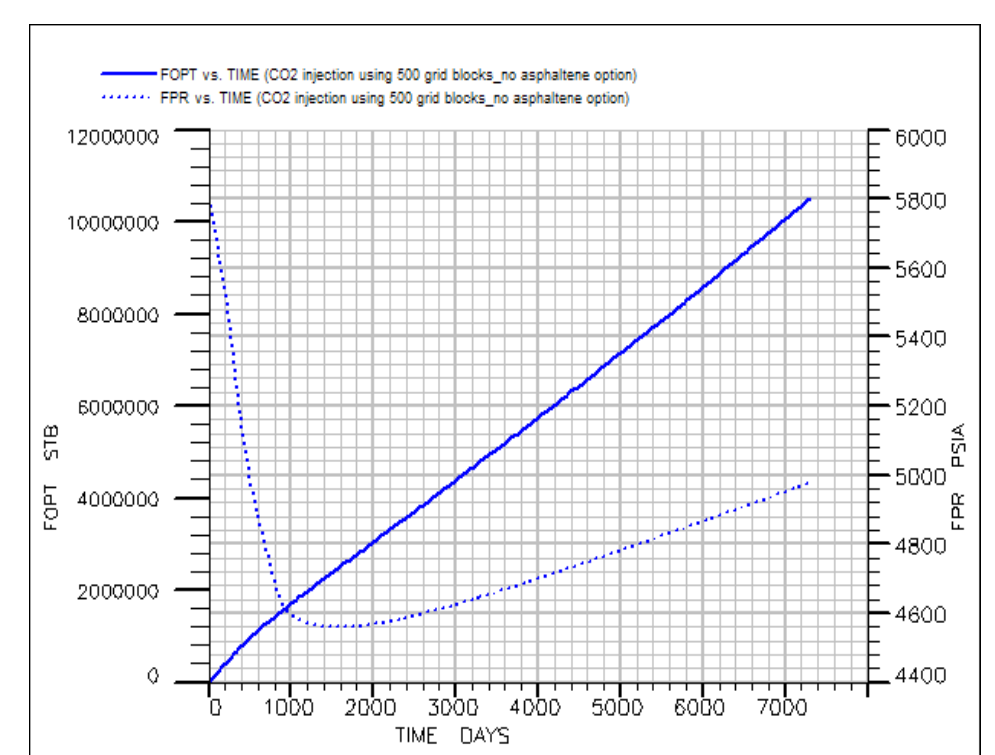
flooding on oil recovery for (a) non-asphaltenic oil, (b) Figure 6. Simulated miscible CO 2 miscible CO injection with three different scenarios (1, 10 and 15 mol % of CO 2 asphaltenic oil, (c) ultimate oil recovery with corresponding field pressure response as a function of mol % of CO in the oil. The thick and dotted lines represent oil recovery 2 (STB) and the corresponding injection pressure (psia), respectively. (d) Effects of pressure, temperature and mol % of CO in the liquid on amount of asphaltene precipitation 2 (wt %)